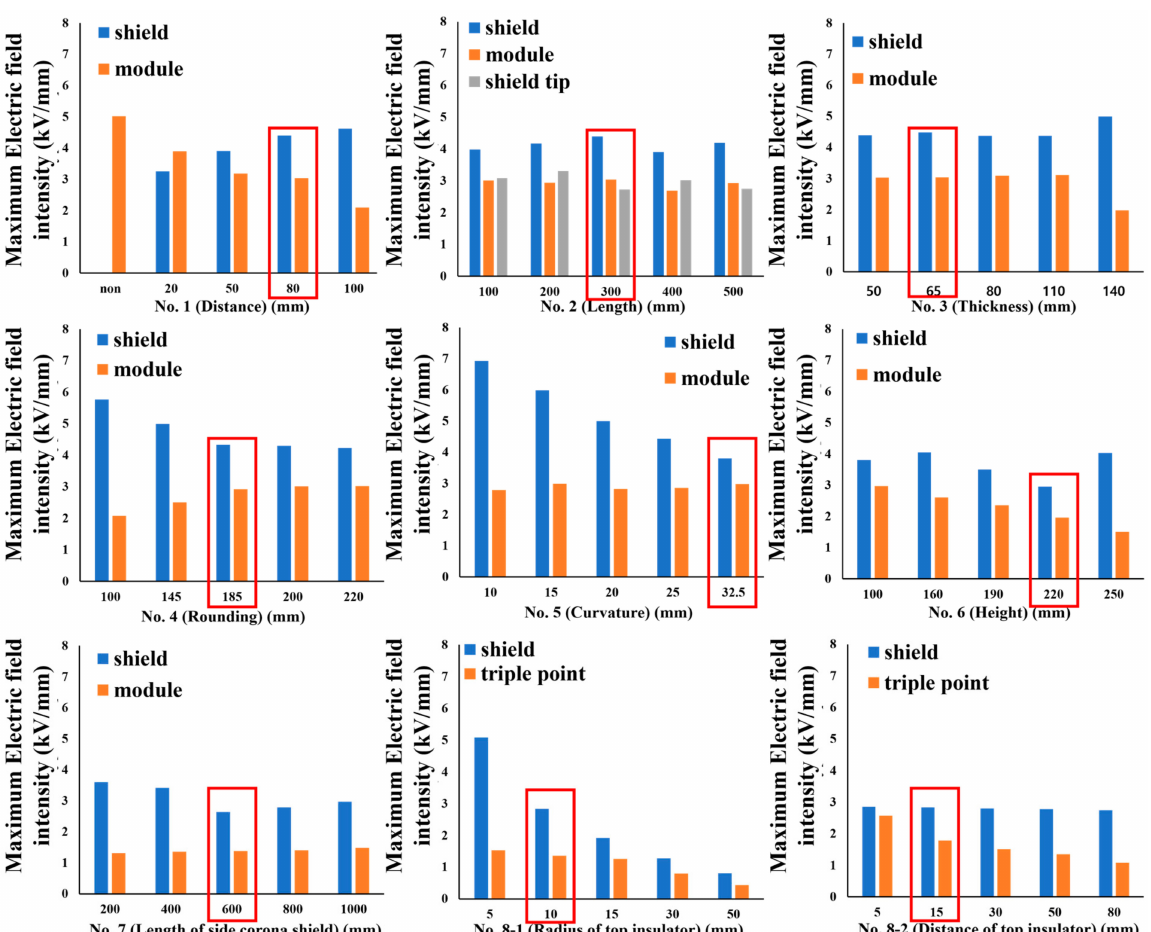
Figure 13. The electrical characteristics of the corona shield according to the design